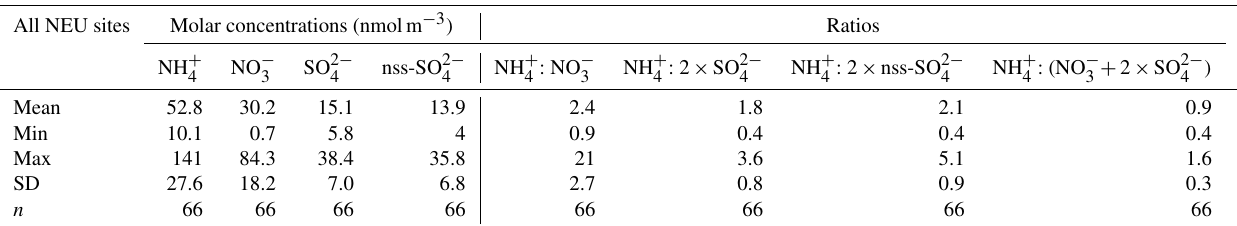
Table 8. Mean molar concentrations of aerosols and ratios measured at sites ( n = 66) in the NEU DELTA ® network. All NEU